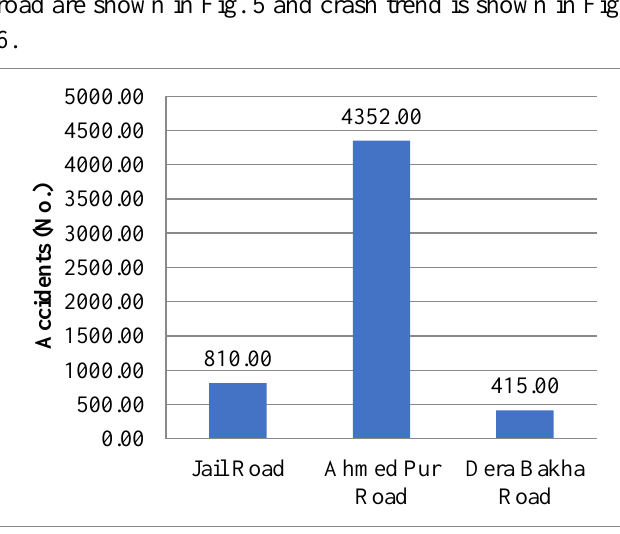
Fig. 5. Number of Accidents